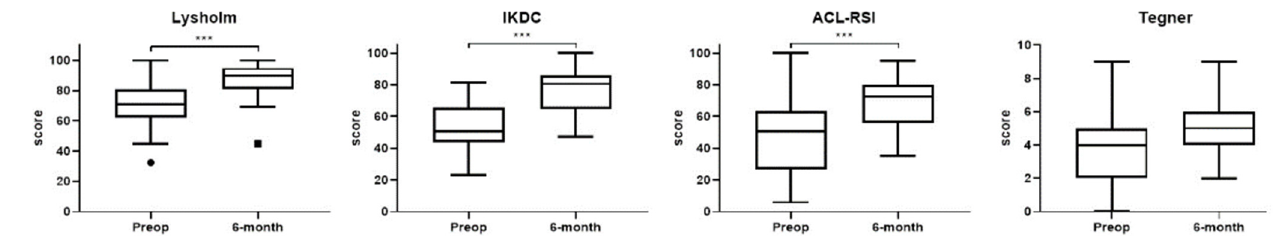
ACL ‐ RSI: Anterior Cruciate Ligament Return to Sport after Injury; SD: standard deviation; BMI: Body Mass.